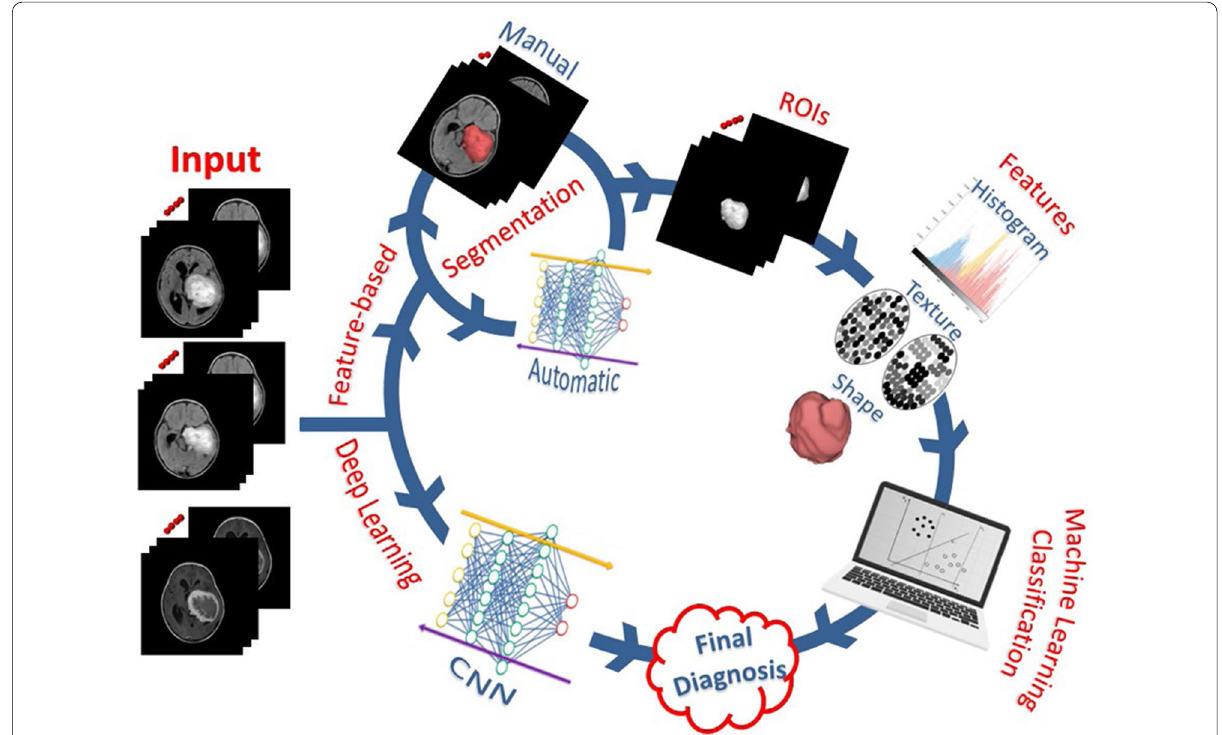
Fig. 1 General framework showing the main steps of the